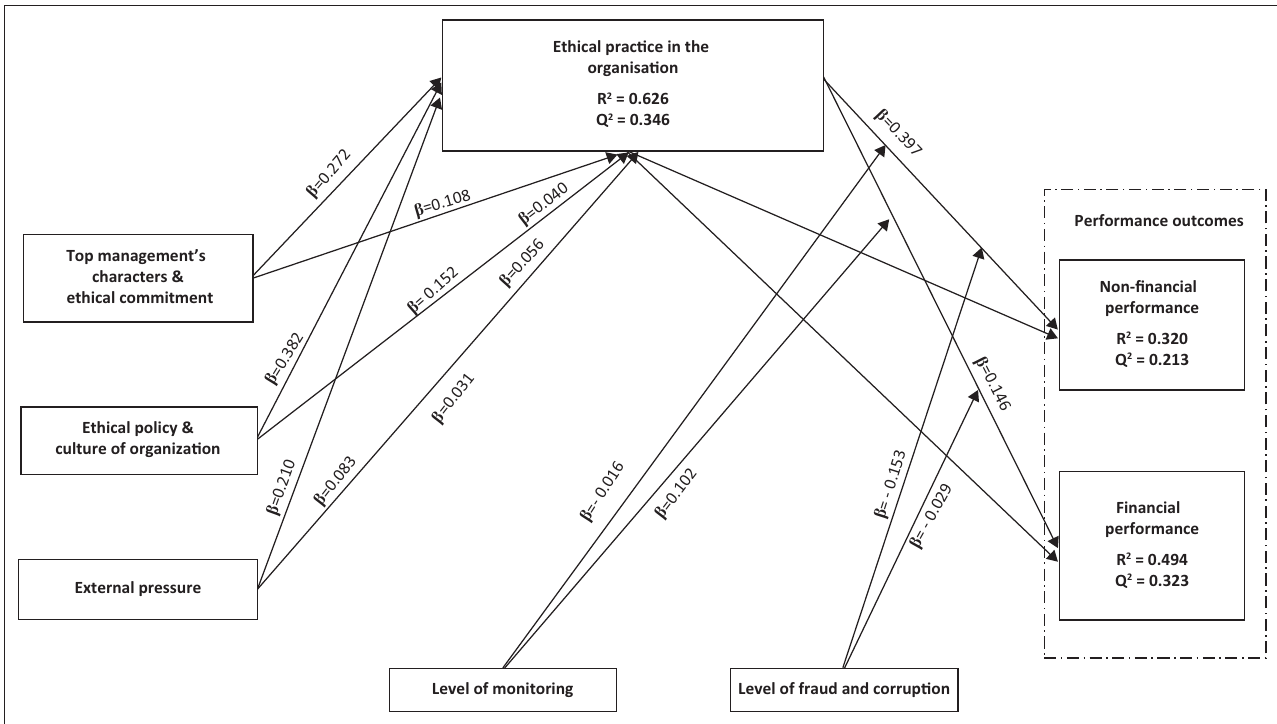
FIGURE 2: Path TABLE 7: Path coefficient. Relationships